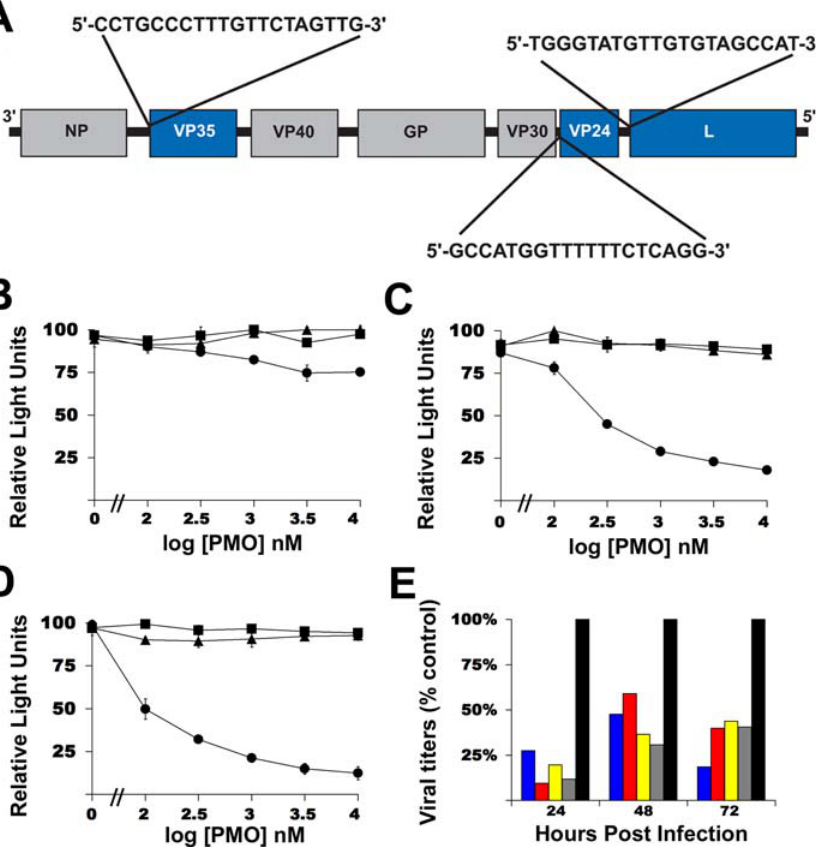
Figure 1. Gene-Specific PMOs Inhibit Ebola Virus Gene Translation and Growth (A) Schematic diagram of the EBOV genome showing the PMO sequences and the relative locations of their mRNA targets. (B–D) Sequence-specific inhibition of EBOV VP24 (B), VP35 (C), and L (D) gene targets in cell-free translation assay. Plasmids containing 150 nucleotides encompassing the PMO target area from EBOV VP24, VP35, or L fused to firefly luciferase were used to generate RNA. Inhibition of the VP24, VP35, or L RNA targets was assessed using in vitro translation reactions containing different concentrations of PMO targeting EBOV ( (cid:1) ) or MARV ( & ) VP24, VP35, or L, respectively, or a scrambled ( m ) PMO, along with the respective RNA. The data are shown as means of three replicates per data point and the standard error of the mean. (E) Inhibition of viral amplification by PMOs in vitro. Vero E6 cells were pretreated for 24 h with 20 l M of EBOV VP24-specific PMO (blue), EBOV VP35- specific PMO (red), EBOV L-specific PMO (yellow), combination of the three EBOV-specific PMOs (gray), or a scrambled PMO (black). The cells were infected with EBOV-Zaire (multiplicity of infection ¼ 1), and the viral titers were assessed at 24, 48, and 72 h post infection. The data are presented as percent reduction of EBOV-specific PMO-treated cells, as compared with the scrambled PMO-treated cells (titers at 24 h were 127 pfu/ml, at 48 h were 4,241 pfu/ml, and at 72 h were 202,000 pfu/ml). The experiments were performed at least three times and a single representative experiment is shown. DOI: